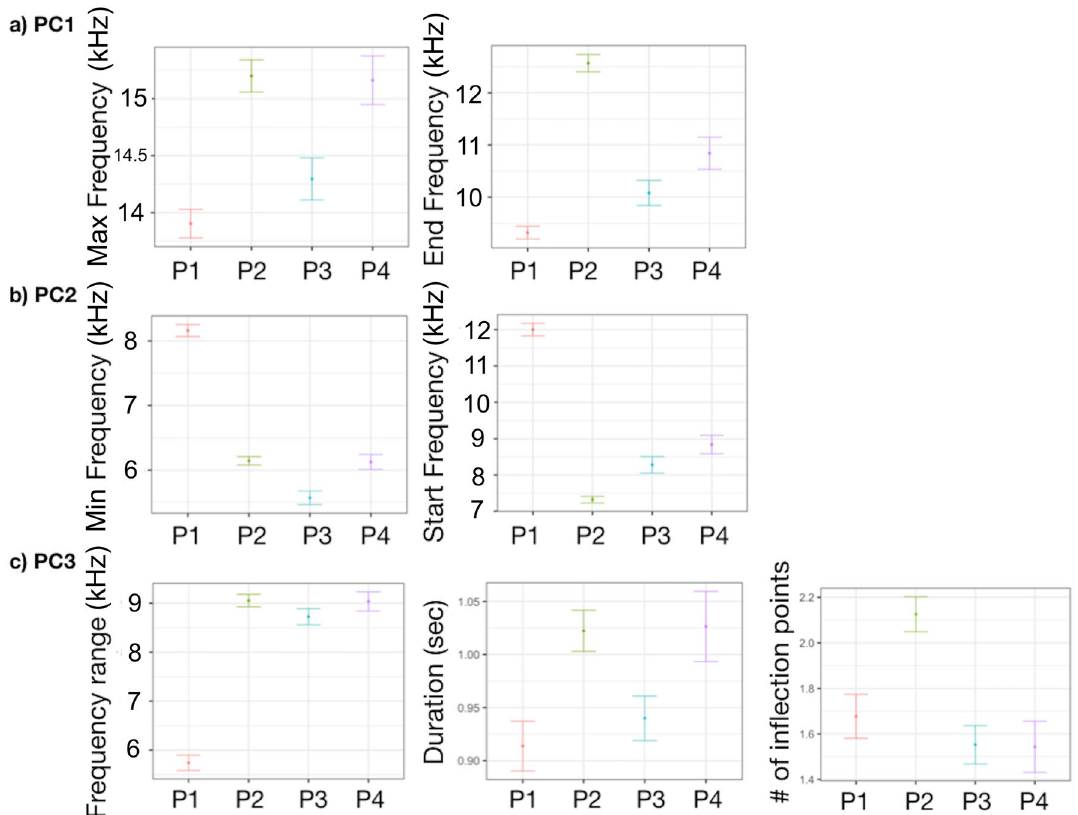
Figure 6. Effect of ‘population demography’ on ( a ) max and end frequencies (PC1), ( b ) min and start frequencies (PC2) and (c) frequency range, duration and number of inflection points (PC3).